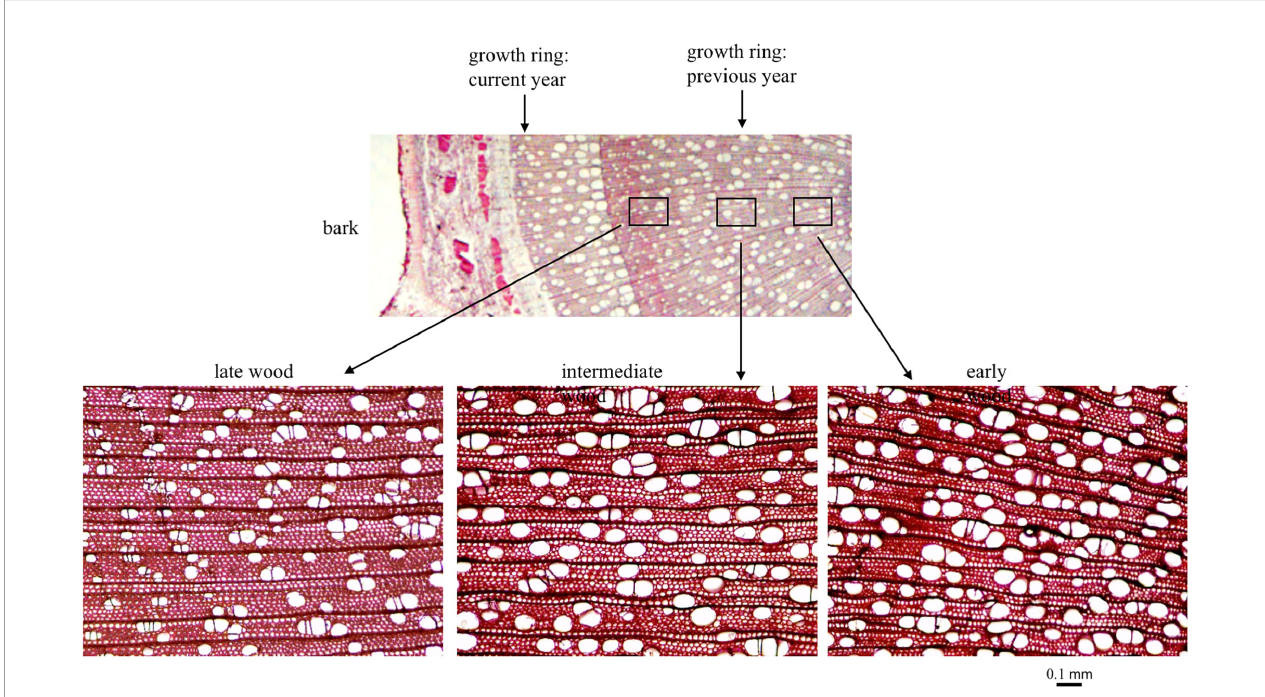
FIGURE 2 | Populus trichocarpa wood cross section from the previous year ’ s growth ring showing variation in early, intermediate and late wood